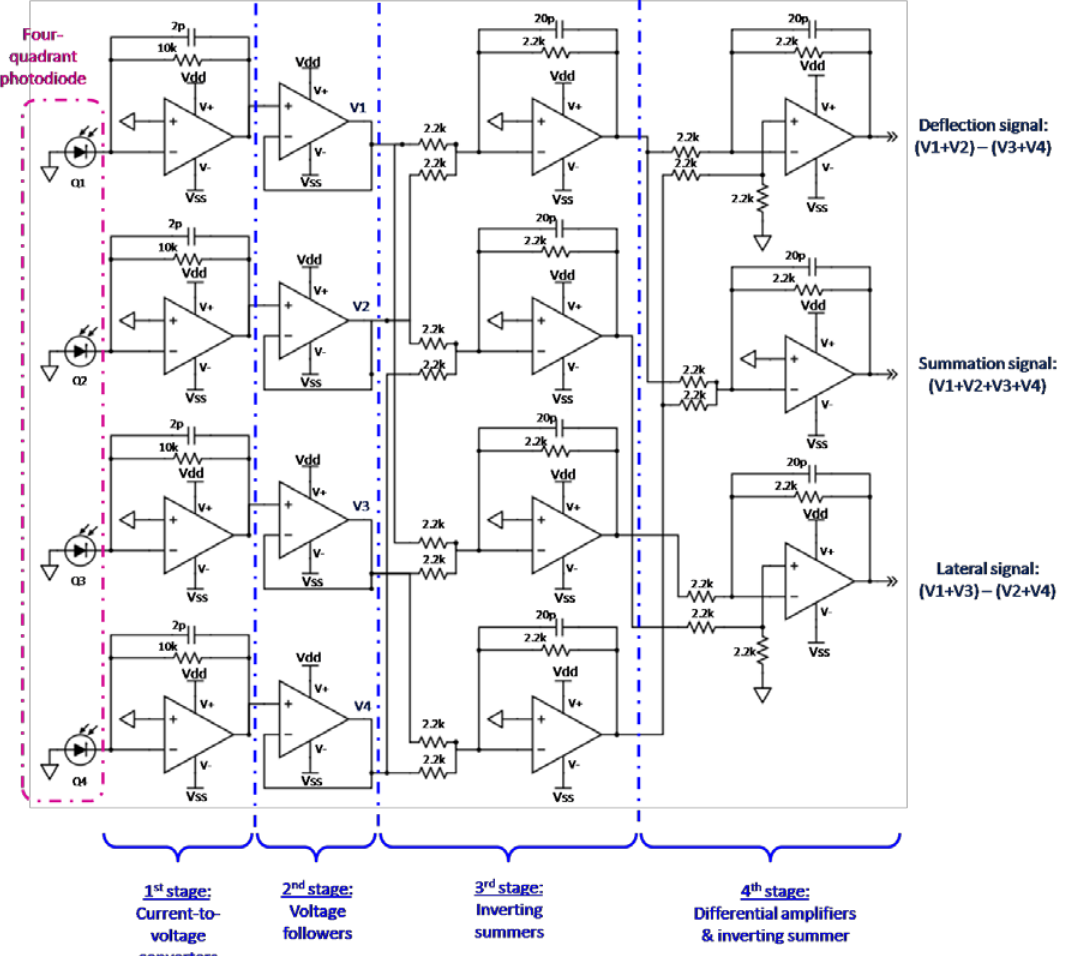
Figure 3. Full circuit diagram of the signal conditioning module. The circuit consists of four stages: current-to-voltage converters, voltage followers, inverting summers, and differential amplifiers. The outputs of the circuits are the deflection signal, summation signal, and lateral signal.